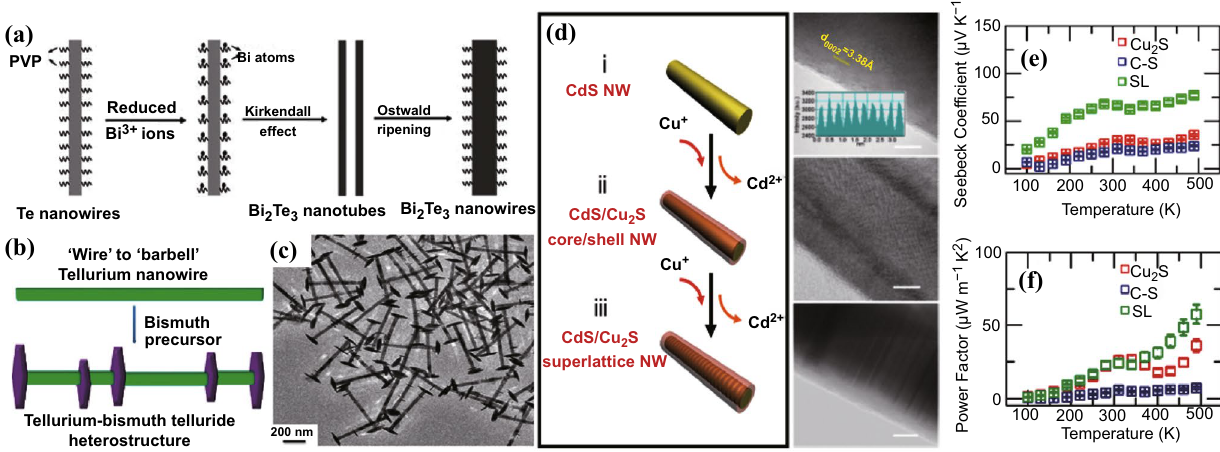
Fig. 8 a Schematic illustrations of the formation mechanism of the Bi 2 Te 3 NWs via a template-assisted solution phase process. b Schematic of tellurium NW formed in the first step and tellurium–bismuth telluride heterostructure after adding bismuth precursor in the second step. c TEM image of the Te–Bi 2 Te 3 heterostructured NWs. d Schematic diagram and corresponding TEM images (scale bar: 5 nm) of phase evolution from pristine CdS NW to CdS/Cu 2 S core–shell NW, and eventually to CdS/Cu 2 S superlattice NW. Temperature dependence of e thermopower and f power factor of Cu 2 S nanowire, CdS/Cu 2 S core–shell nanowires (C–S) and CdS/Cu 2 S superlattice nanowires (SL). Adapted with permission from Refs. [115, 120,